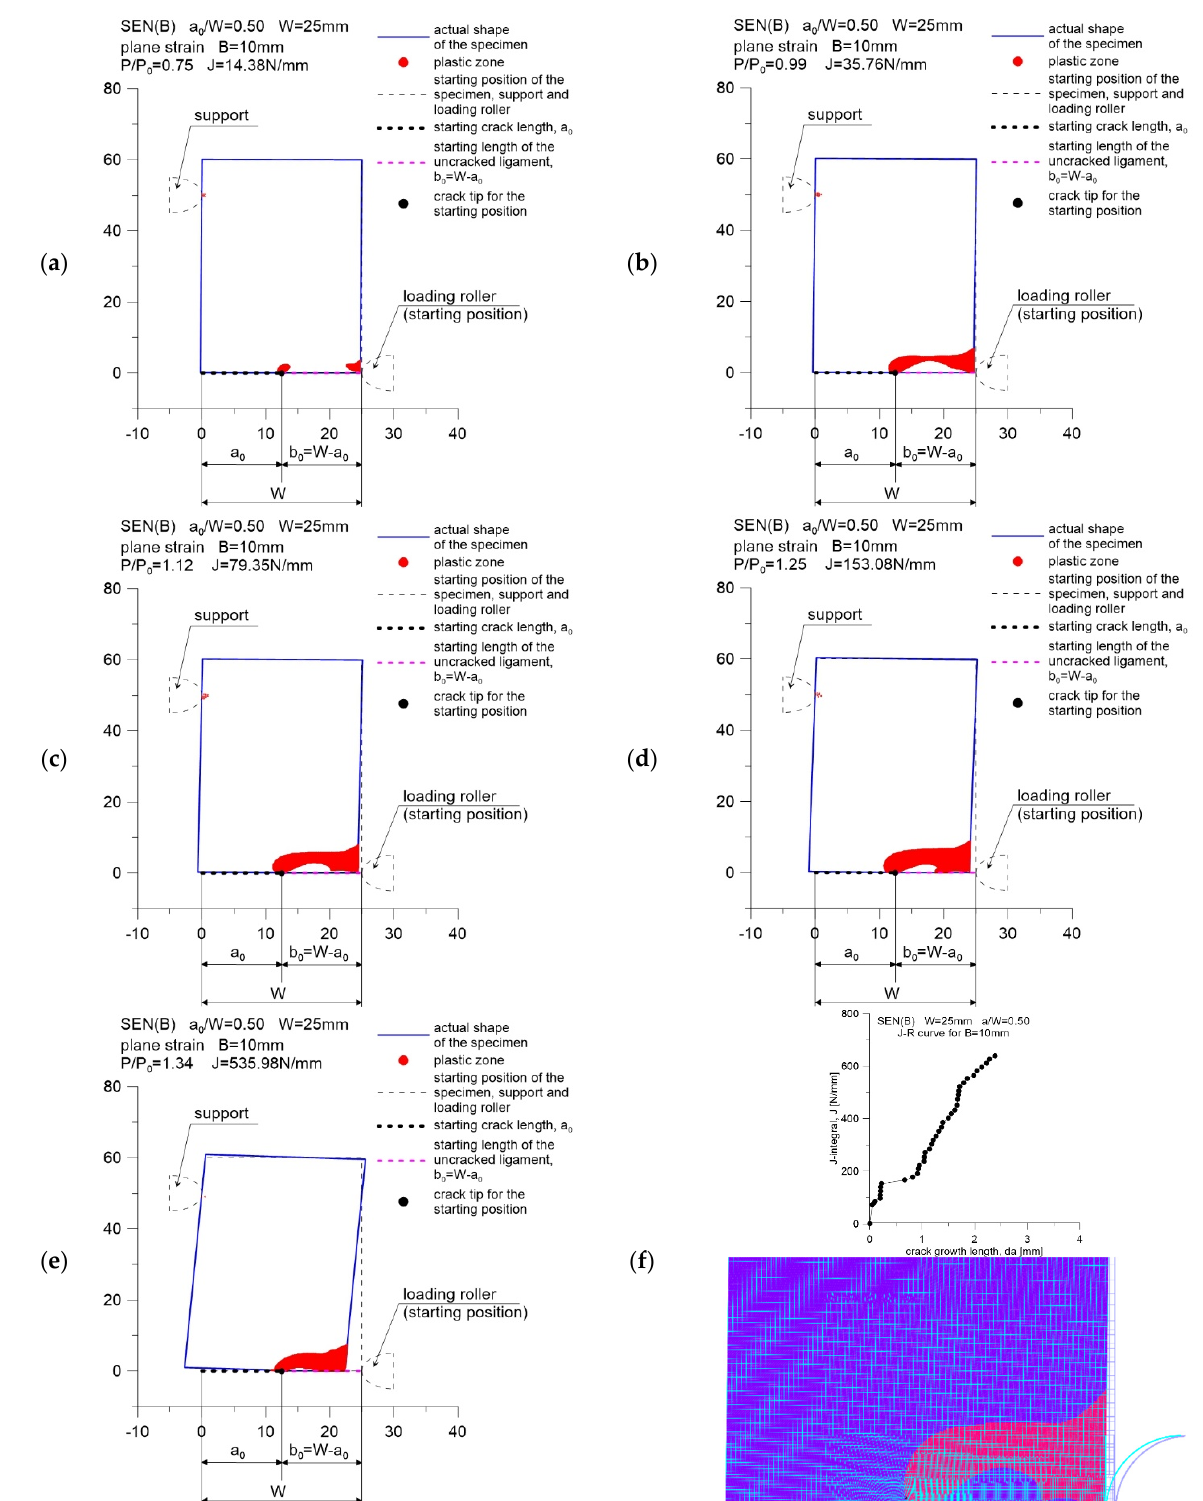
Figure 5. Change in the size of the plastic zone for the SEN(B) specimen, made of 41Cr4 steel, with a thickness of B = 10 mm. Specimen number in Table 1: 10.1: ( a ) results for P / P 0 = 0.75 and J -integral J = 14.38 N/m; ( b ) results for P / P 0 = 0.99 and J -integral J = 35.96 N/m; ( c ) results for P / P 0 = 1.12 and J -integral J = 79.39 N/m; ( d ) results for P / P 0 = 1.25 and J -integral J = 153.08 N/m; ( e ) results for P / P 0 = 1.34 and J -integral J = 535.980 N/m; ( f ) the J - R curve for specimen and the shape of plastic zone for last point from J-R